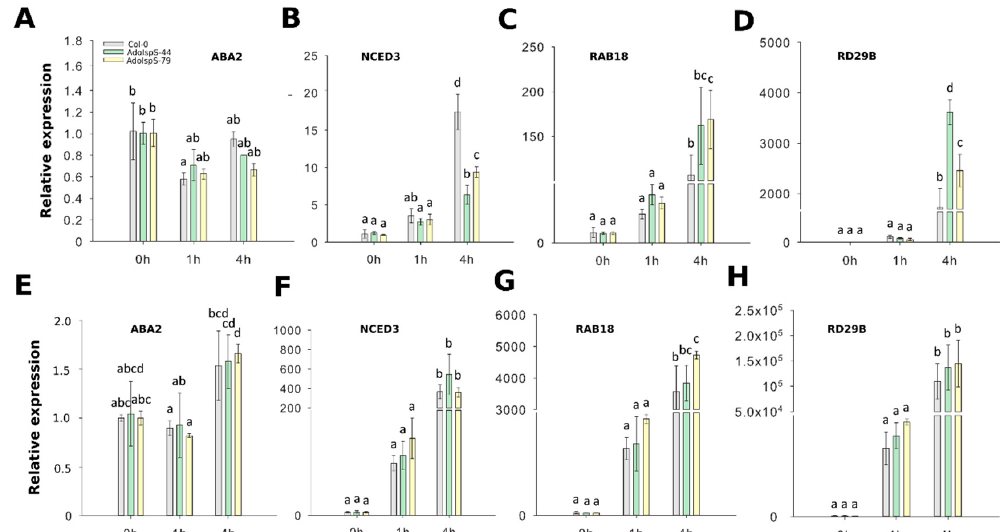
Figure 3. Expression of ABA biosynthetic and signaling genes in response to ABA and PEG